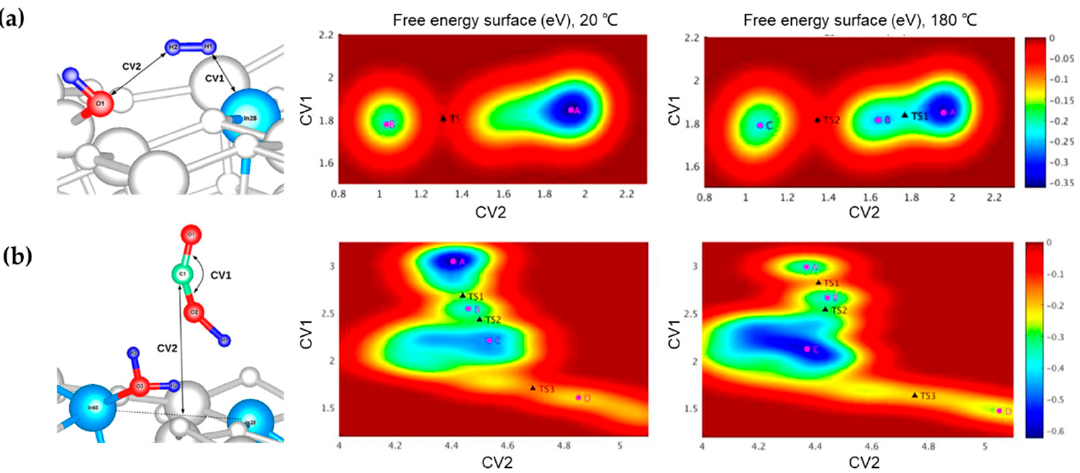
Figure 6. Collective variables (CVs) used in metaD AIMD simulations of the free energy surfaces of ( a ) H 2 dissociation and ( b ) CO 2 reduction catalyzed by In/O FLP at 20 and 180 °C. Color scheme: catalyst surface, white; LA (In), light blue; H, blue; O, red. Adapted from reference [81] with